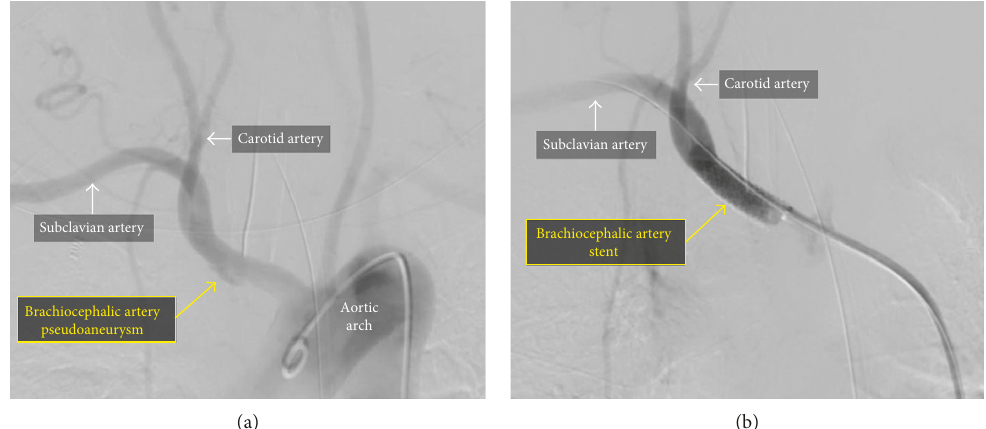
Figure 4: Angiography of the brachiocephalic artery demonstrating a small pseudoaneurysm (a). There was an excellent angiographic result after deployment of a covered stent